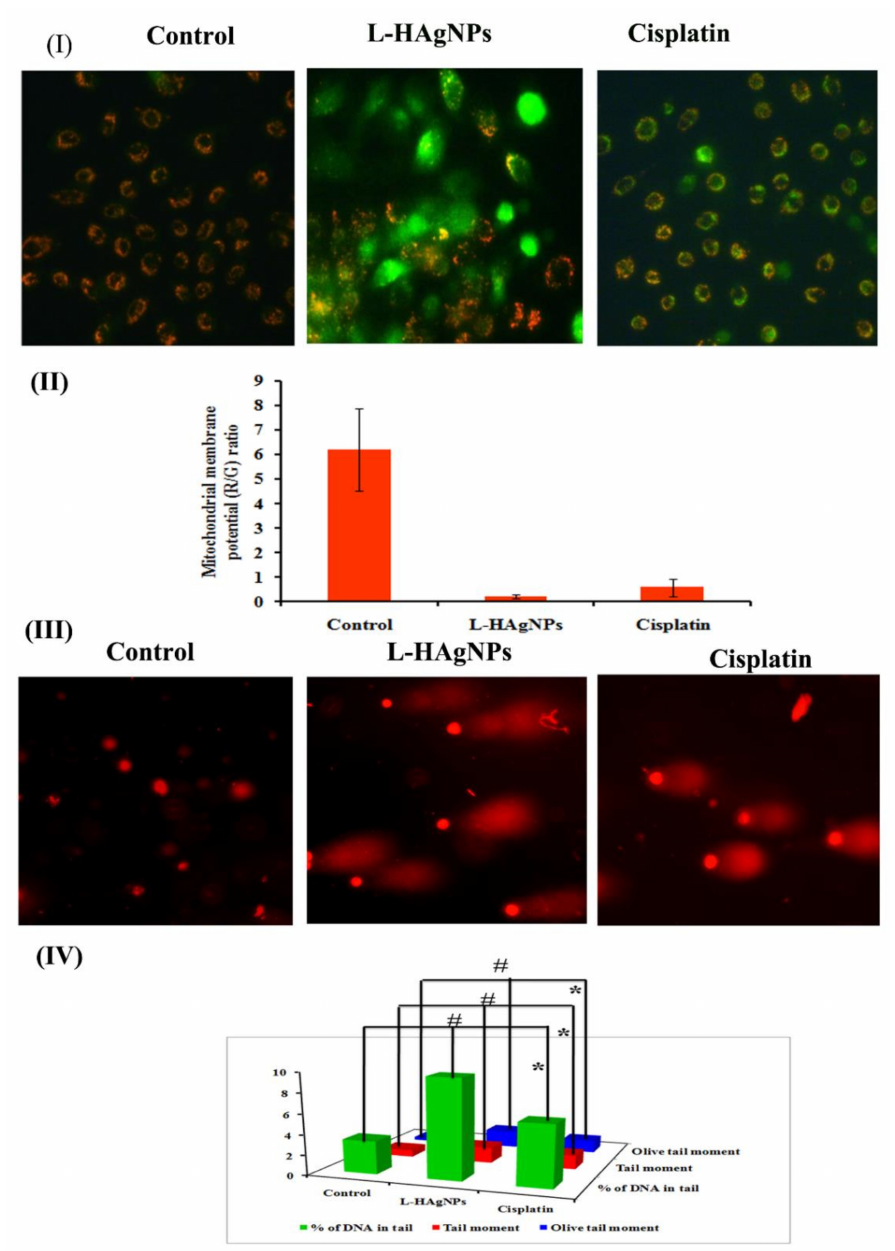
Figure 6. ( I ) Fluorescent micrograph revealing transmembrane potential of cells treated with L- HAg NPs; ( II ) bar graph representing quantification of MMP; ( III ) fluorescent microscopic images revealing DNA damage induced by L-HAgNPs; ( IV ) quantitative measurement of degree of DNA damage. Data are expressed as mean ± SD of triplicate assays. Images were captured at 20 × magnification, respectively. # and * p < 0.0001 denotes statistical significance between control vs. L-HAgNPs treated groups and control vs. cisplatin-treated